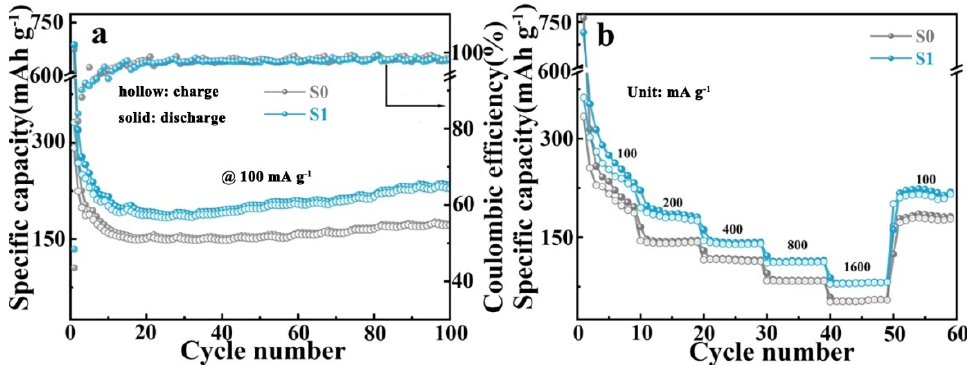
Figure 5. ( a ) Cycling performance at 100 mA g − 1 and the corresponding Coulombic efficiency, and ( b ) rate capabilities at different current densities of S0 and